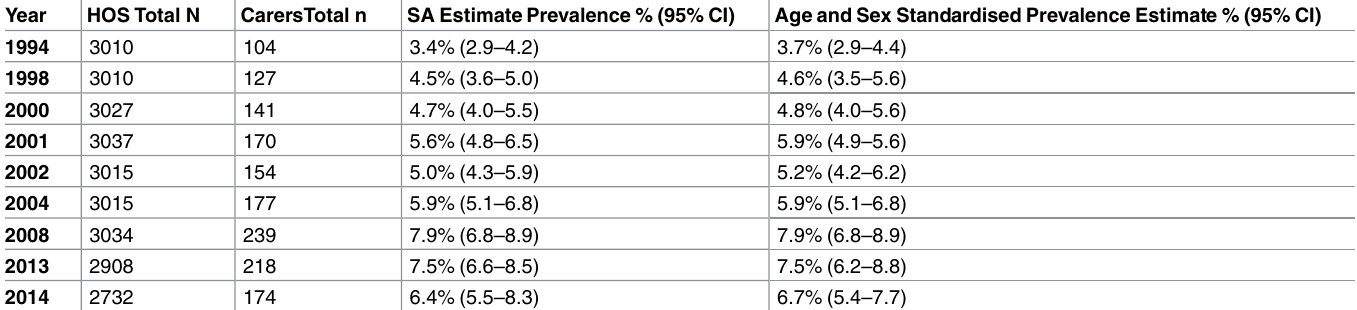
Table 1. Crude& Age / Sex StandardisedPrevalence Estimates of AdultCarers, SouthAustralia1994–2014.